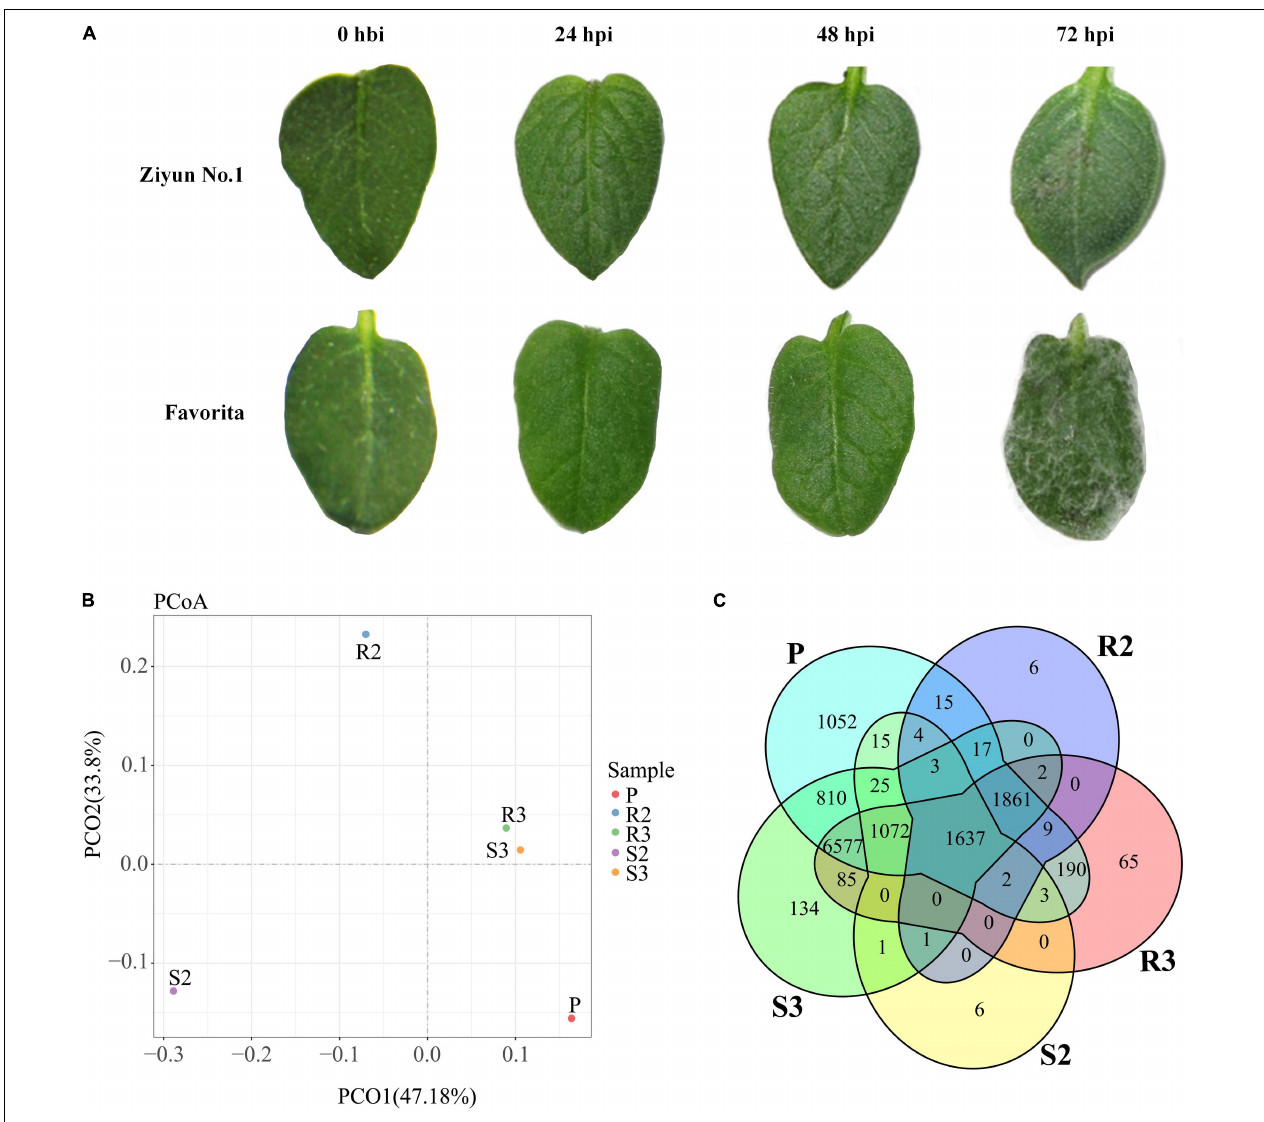
FIGURE 1 | Infection response and global transcriptomic response of Phytophthora infestans ( P. infestans ). (A) phenotypic responses of Solanum tuberosum cv. Favorita and Ziyun No.1 to the infection of P. infestans . (B) Principal coordinates analysis (PCoA) of P. infestans genes. (C) Venn diagrams of the P. infestans genes expressed in different samples. Hbi, hours before inoculation; hpi, hours post-inoculation. R1, R2, and R3 present samples collected at 0 hbi, 24 hpi, and 48 hpi in incompatible interaction. S1, S2, and S3 present samples collected at 0 hbi, 24 hpi, and 48 hpi in compatible interaction. P presents zoospore sample of P. infestans